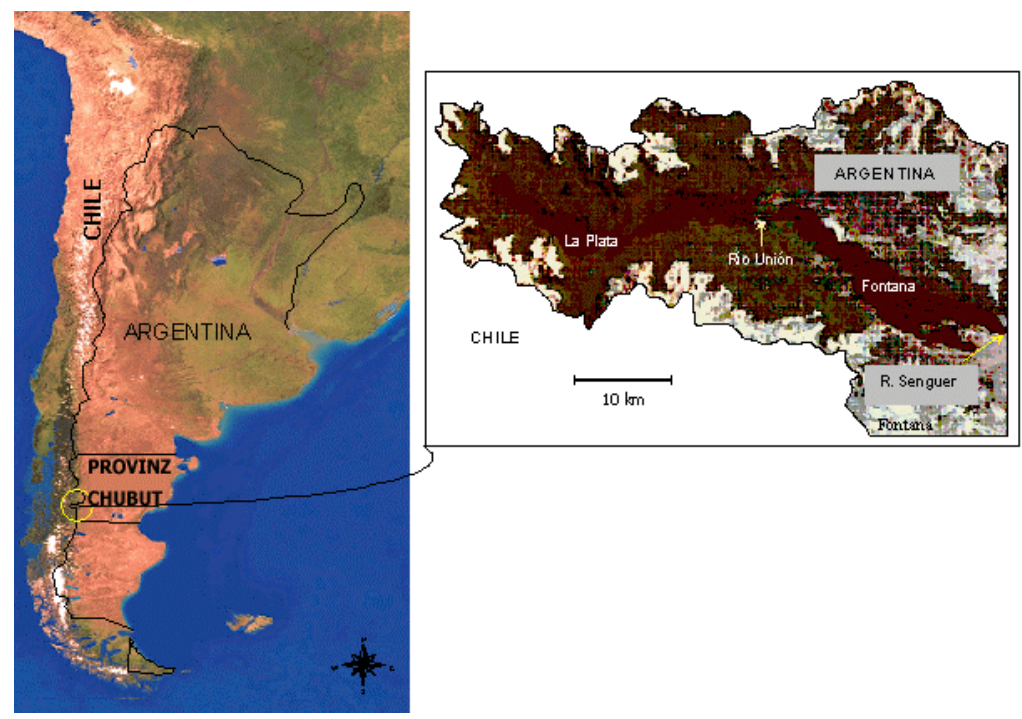
FIGURE 1 . Position of the investigated area in Argentinian Patagonia. Left: Satellite picture, Planetary Visions 2000 (political borders are represented roughly); right: Landsat 5 TM (3,2,1) of